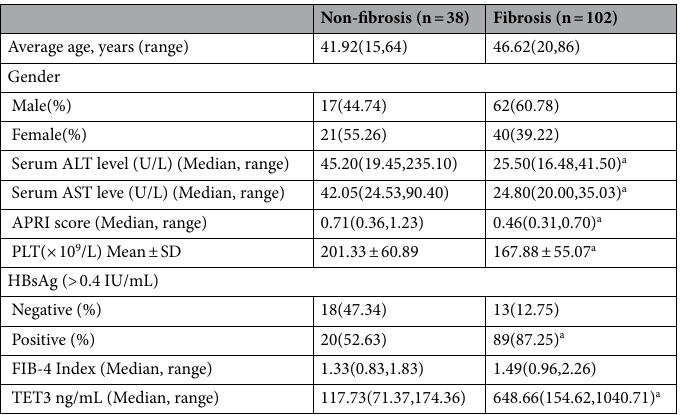
Table 2. Comparison of the clinical characteristics of patients with and without non-fibrosis. a P < 0.05 versus Non-fibrosis. ALT , alanine aminotransferase; AST , aspartate aminotransferase; FIB-4 , fibrosis-4; APRI , AST to platelet ratio Index; PLT , platelet count; HBsAg , Hepatitis B surface antigen; TET3 , Ten-eleven translocation protein 3.